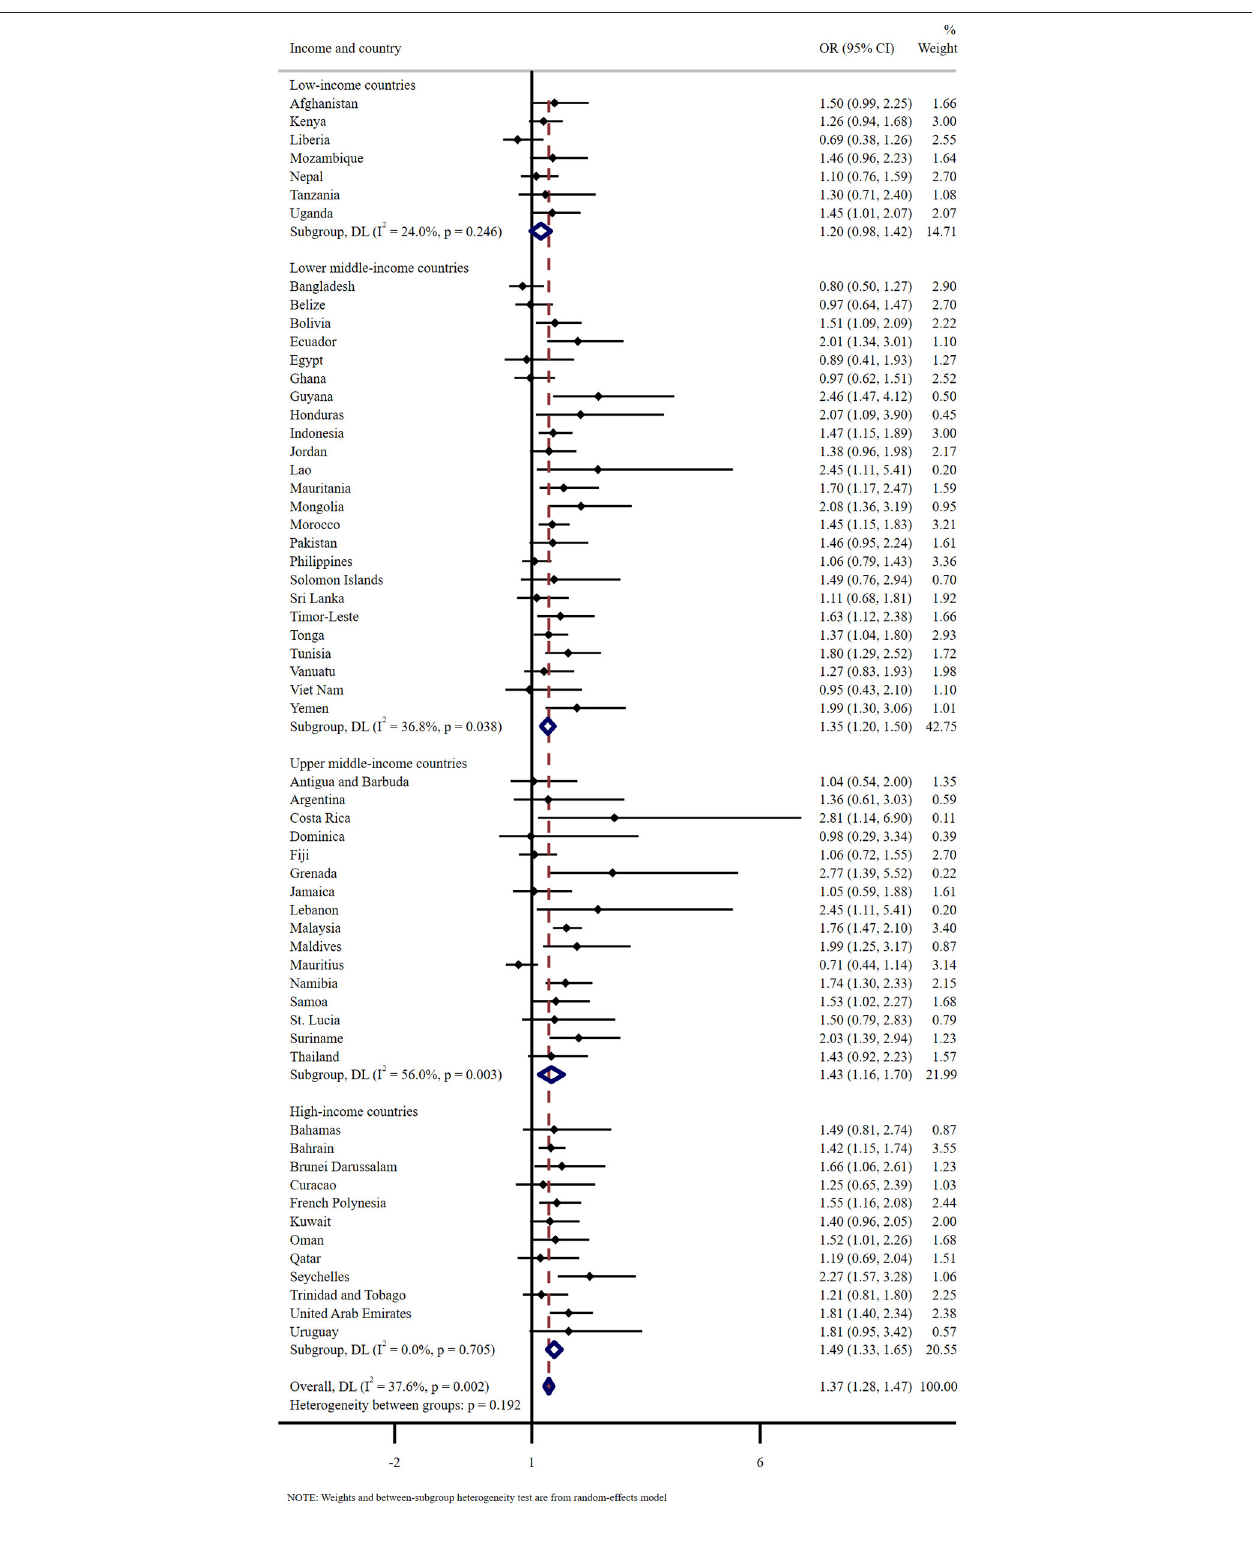
FIGURE 1 | Overall and country-stratified association between food insecurity and bully victimization. The reference category is no food insecurity. Sex, age, physical fighting, current cigarette use, loneliness, number of close friends, peer support, parental connectedness, and parental bonding were adjusted. Overall estimates were obtained by meta-analysis with random